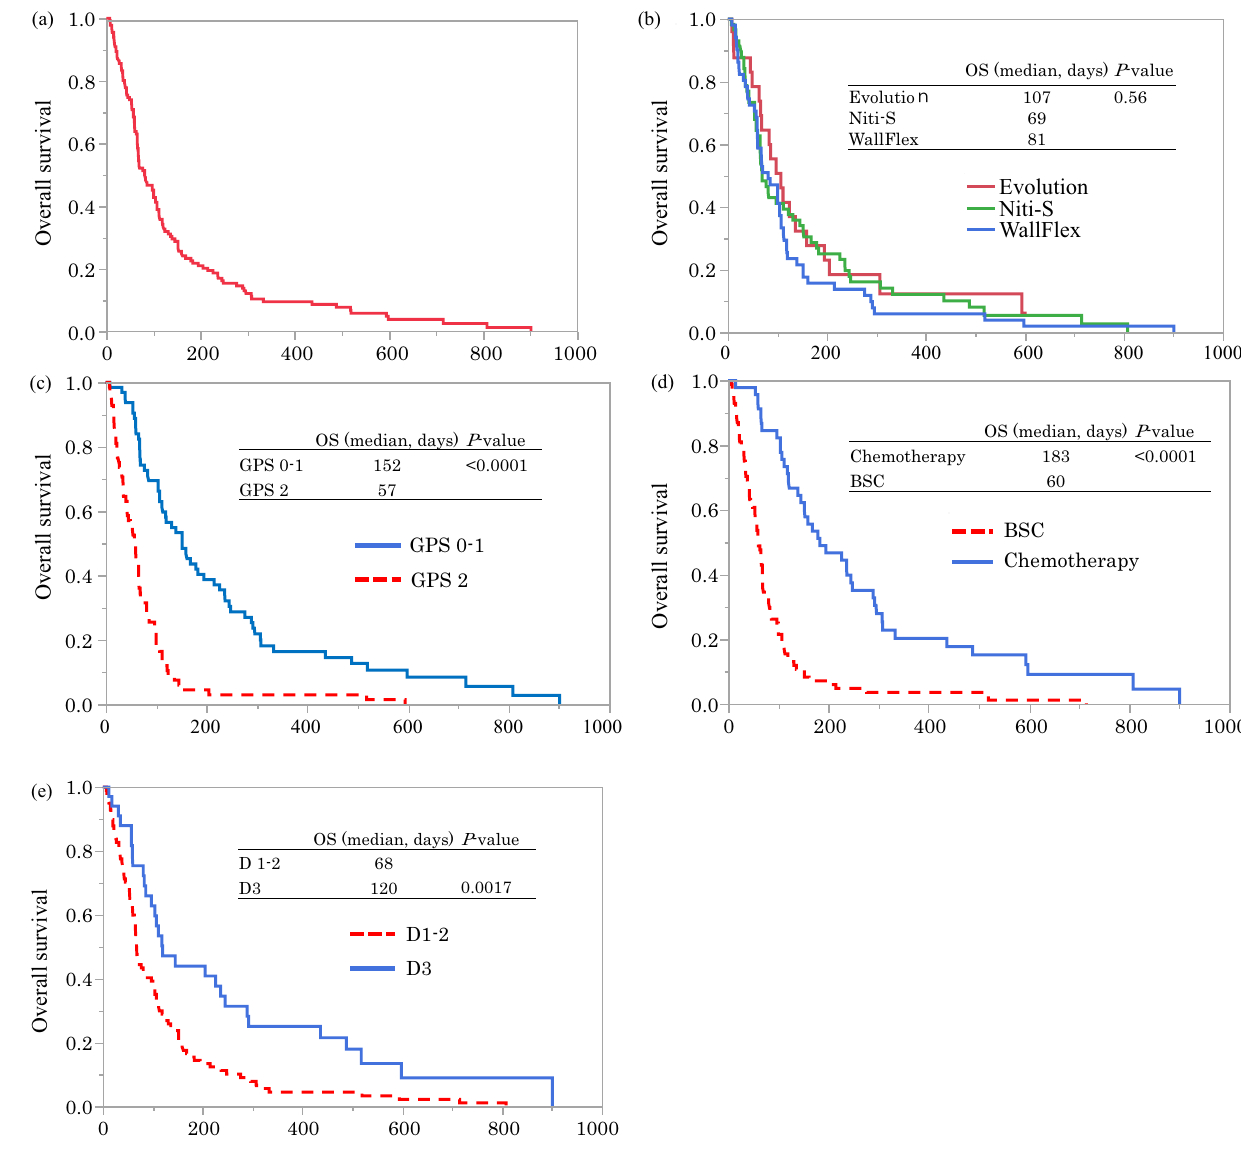
Figure 1. Kaplan–Meier curves for overall survival (OS) after duodenal stent (DS) placement. ( a ) OS of all patients enrolled in this study. The median OS after DS placement was 81 (7–901) days. ( b ) OS according to stent types. No significant differences were observed. ( c ) OS according to a GPS of 0–1 or 2. The median OS for a patient with a GPS of 0–1 was significantly longer compared with that for a patient with a GPS of 2. ( d ) OS of patients with chemotherapy or best supportive care (BSC) after DS placement. The median OS of the chemotherapy group was significantly longer compared with that of the BSC group. ( e ) OS of patients with duodenal strictures in D1-2 or D3. The median OS of the D3 stricture group was significantly longer compared with that of D1-2 stricture